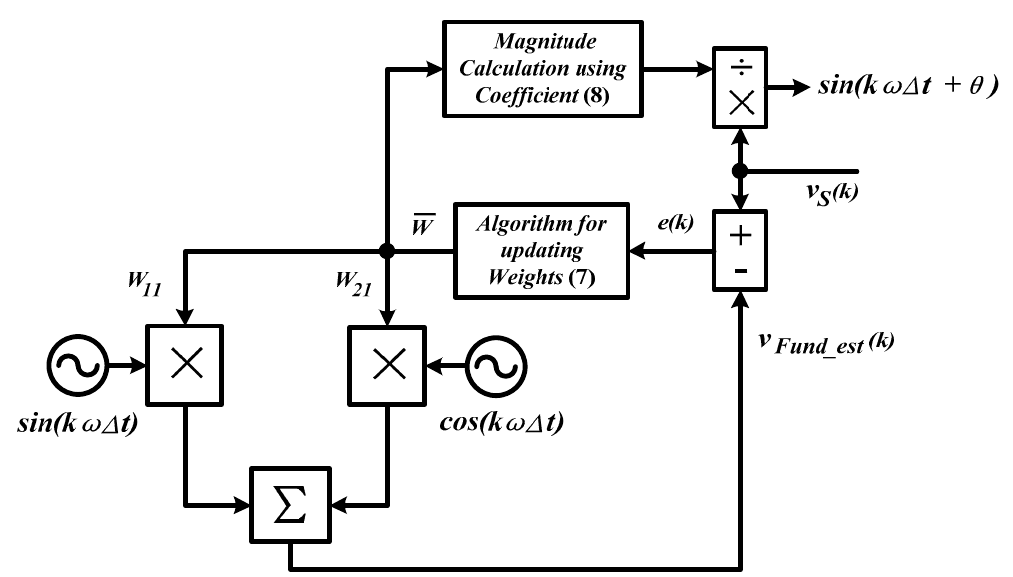
Figure 8. Control structure of adaptive linear neuron (ADALINE)-based synchronization technique [58]. At the same time, W 11 and W 21 will be utilized to compute instantaneous magnitude V Fund _ mag ( k ) of v S ( k ) according to the following